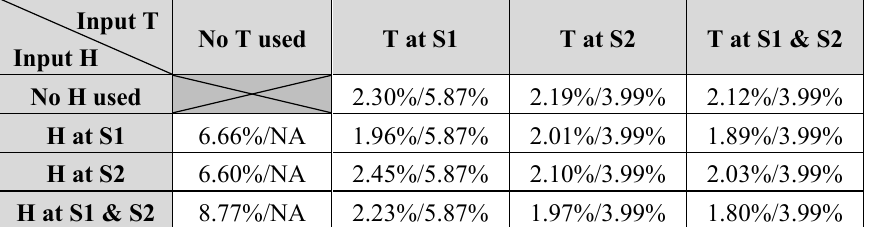
Table 1. Data Estimation results (% error ANN/% error interpolation) for Temperature (T) in Sensor 3 (S3), combining Temperature (T) and Humidity (H) in Sensors 1 and 2 (S1 and S2) as input.